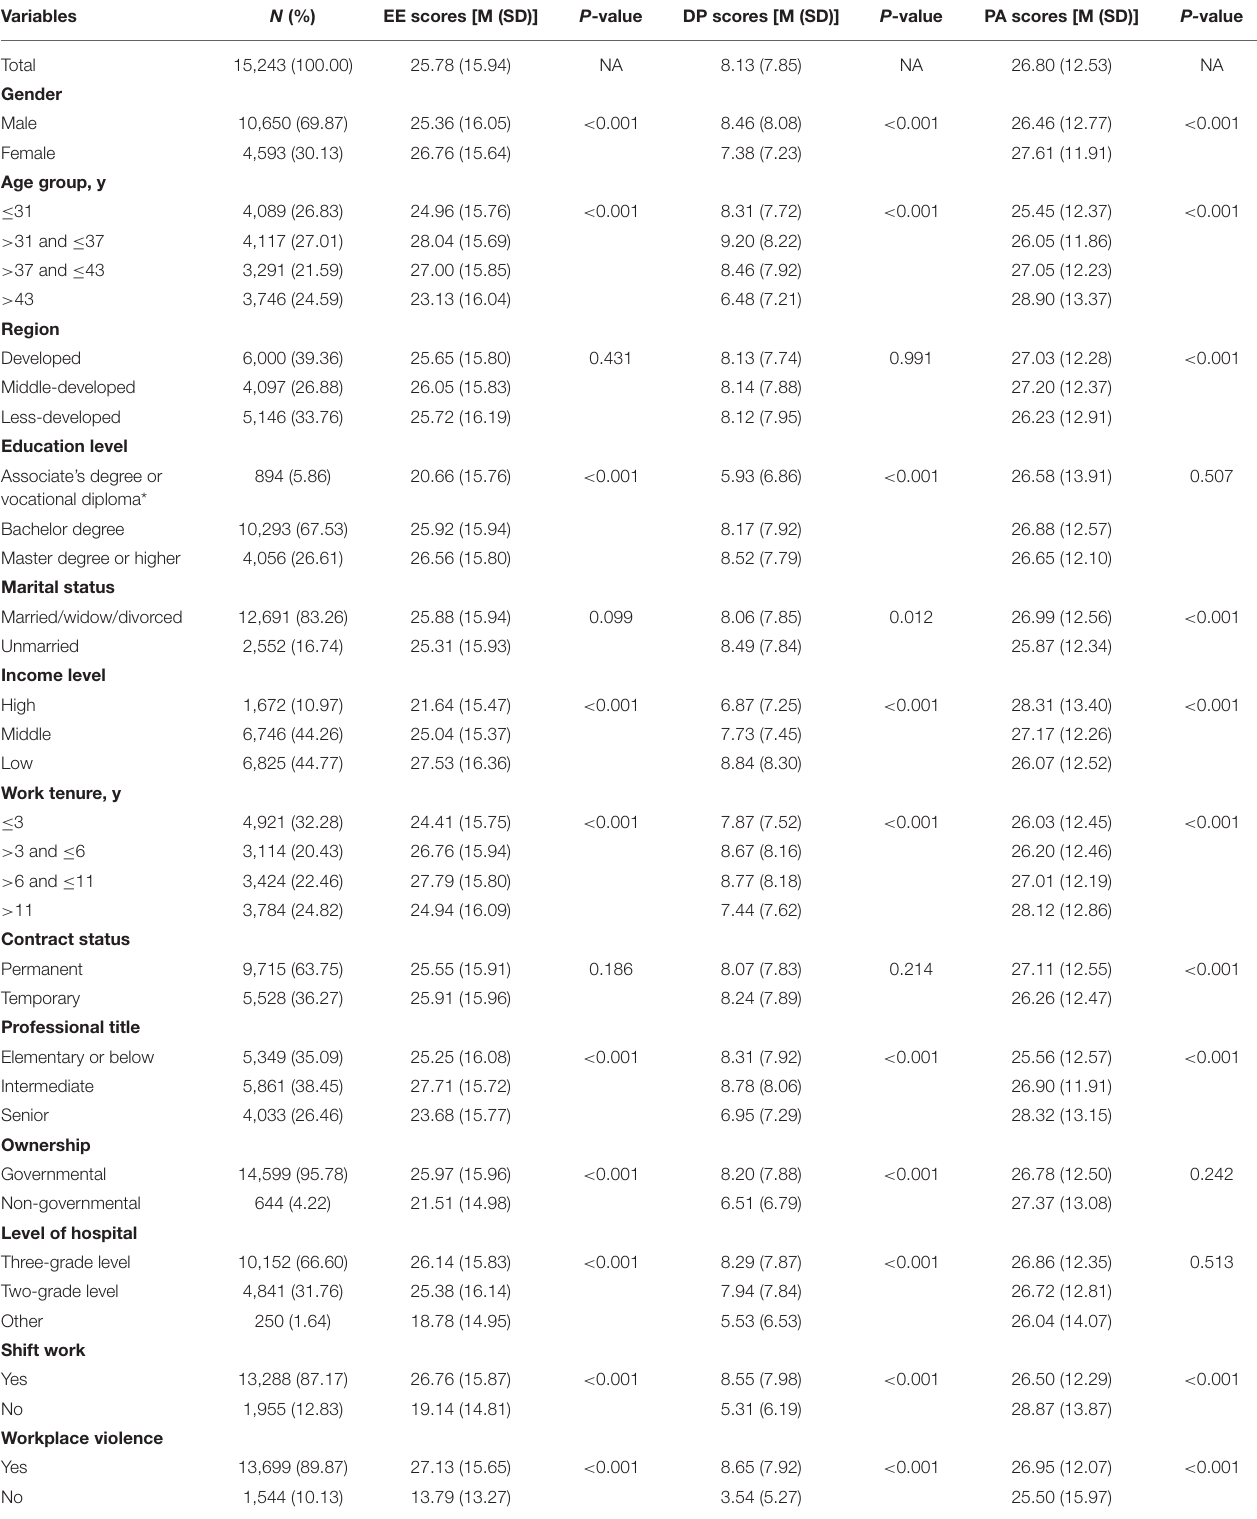
TABLE 1 | Statistical description of study